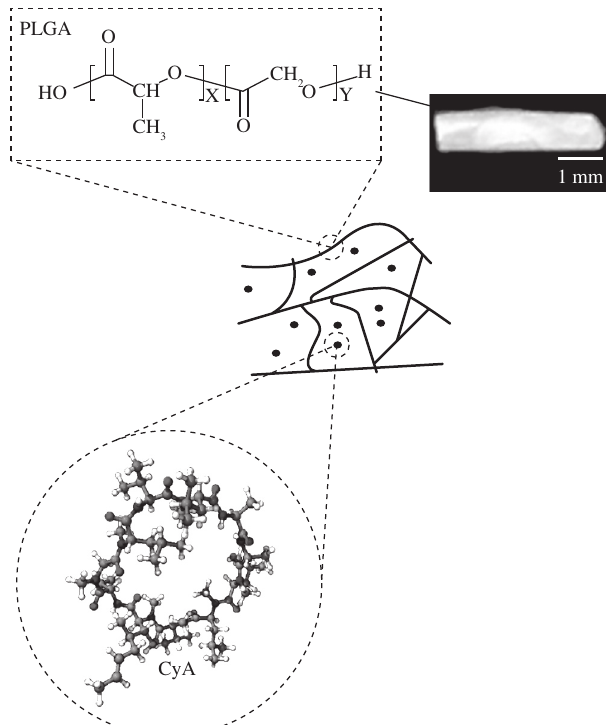
Figure 1. Picture of the developed implants from the mixture